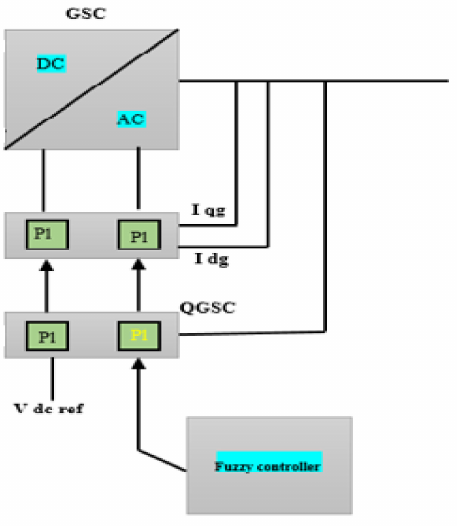
Figure 6. Location of fuzzy controller in the GSC